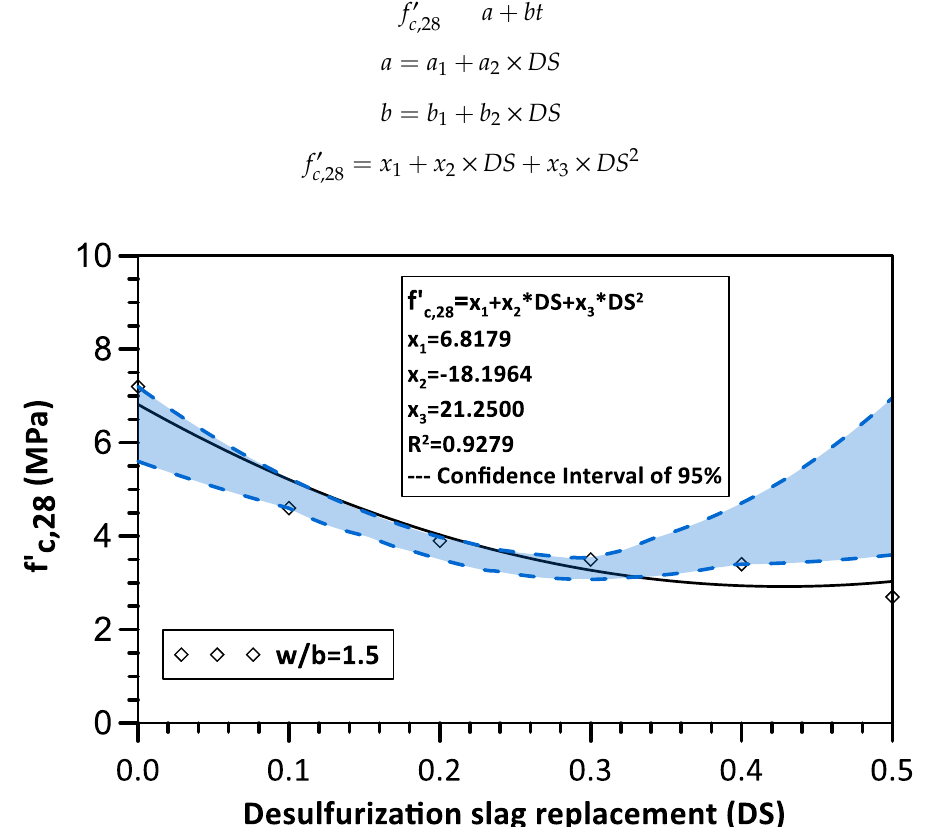
Figure 10. The relationship between the compressive strength of the CLSM, DS content, and coe ffi cient x on the 28th